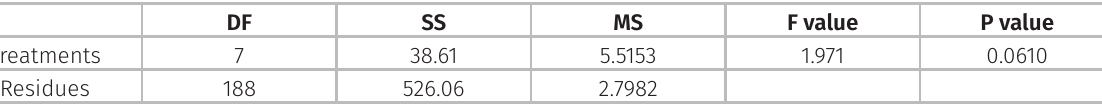
Table III. Analysis of variance of the MRF of the jejunum of cadavers of cats chemically preserved under the acute effect of conservation for seven days. DF SS MS F value P value Treatments 7 38.61 Residues